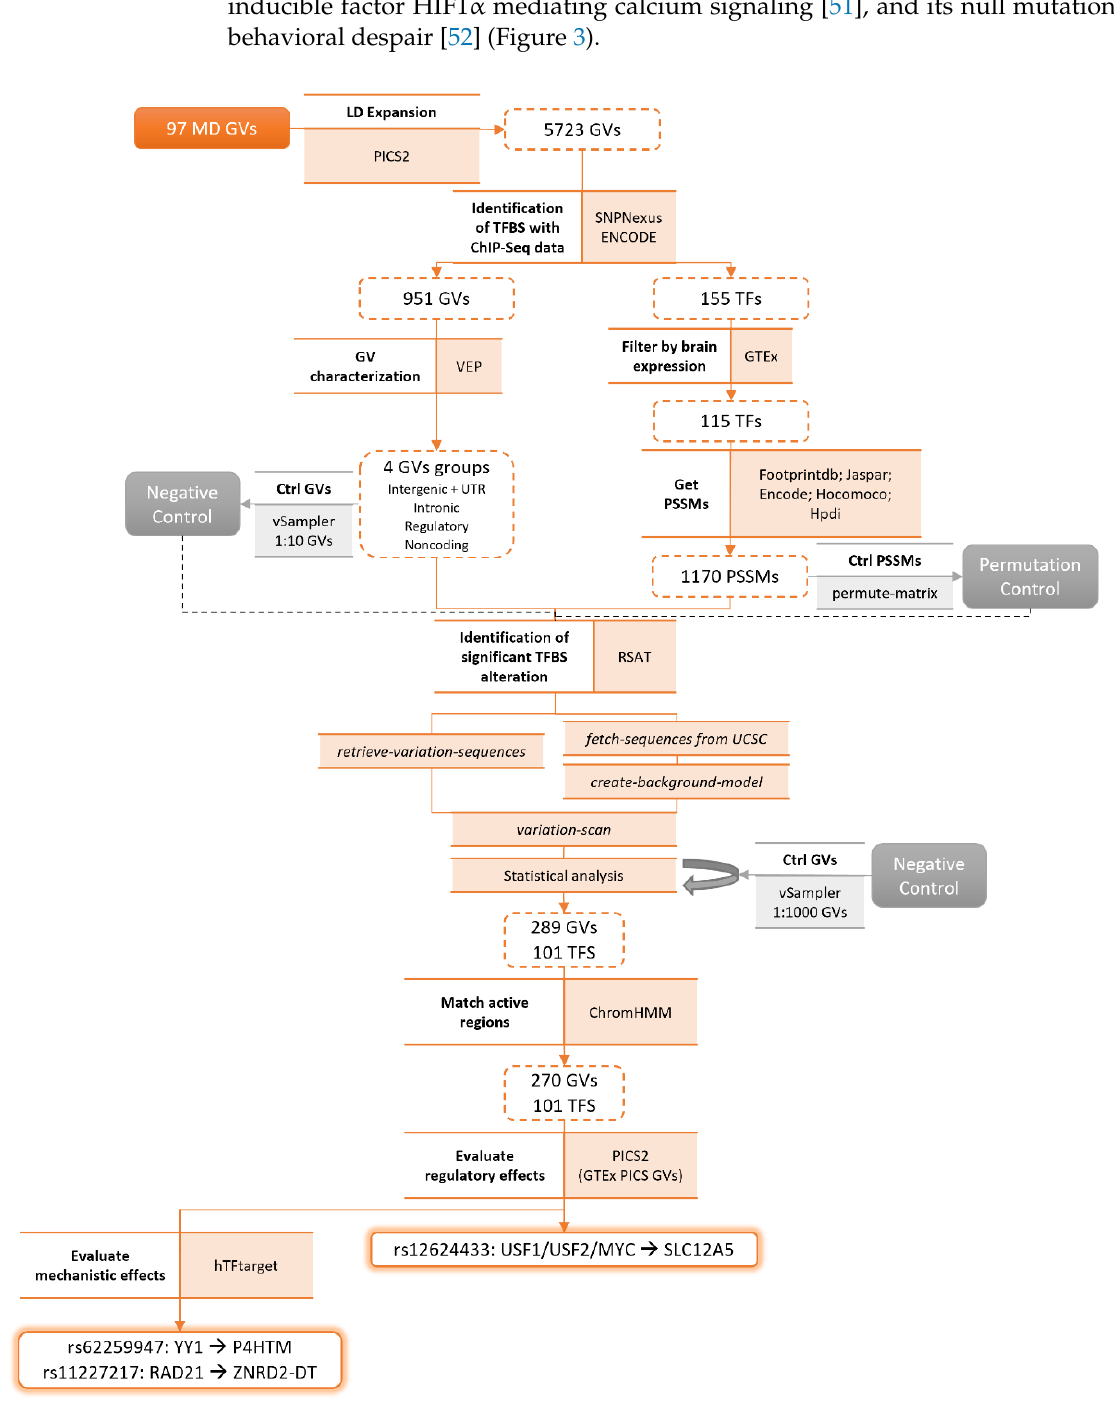
dence of their impact on gene expression regulation by evaluating their annotation to